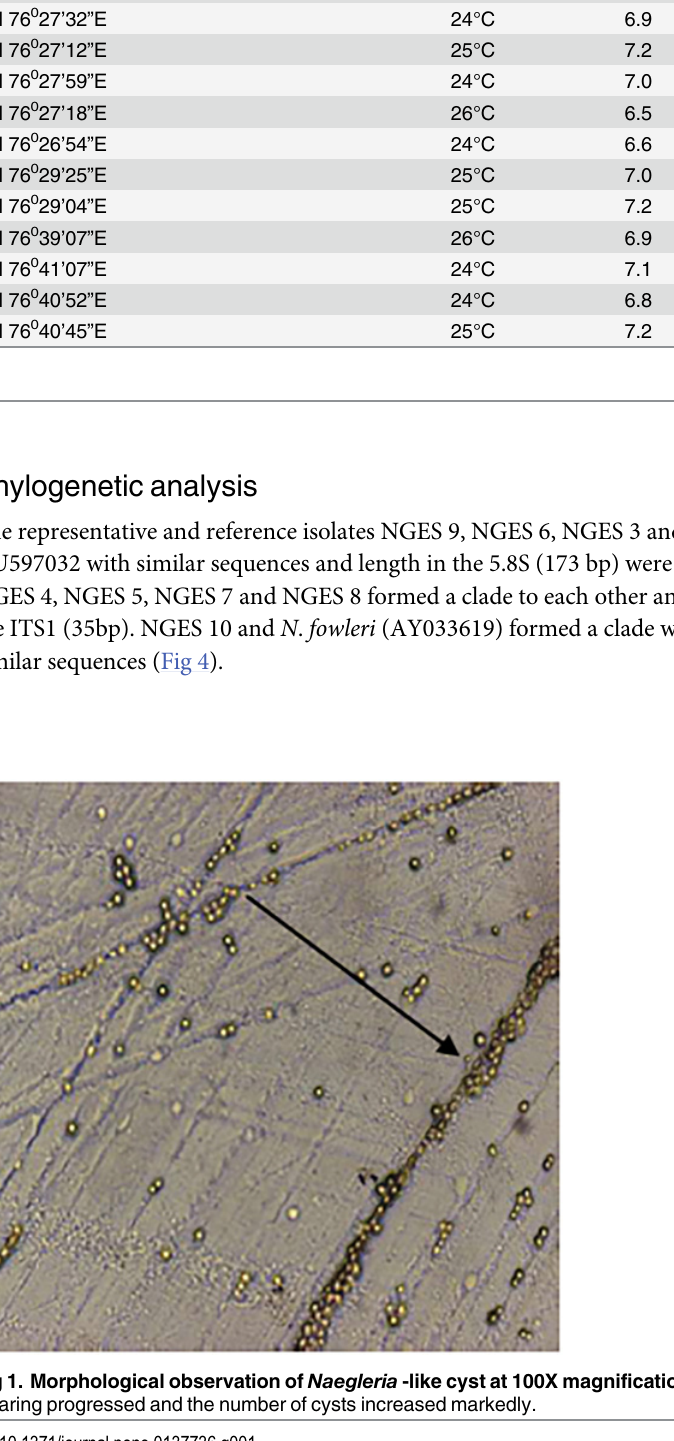
Fig 1. Morphological observation of Naegleria -like cyst at 100X magnification. Zone of Escherichia coli clearing progressed and the number of cysts increased markedly.